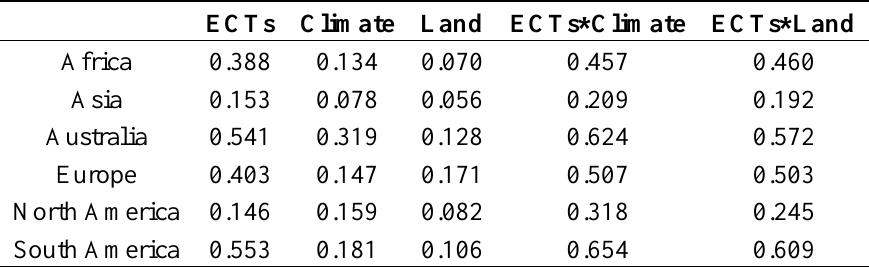
Table 2. Adjusted R 2 values of the univariate one- and two-way Anova models in explaining variance of the FPAR3g-SPEI12 correlations with the ERTs, Köppen climate zones, land use and their combinations as predictors. All models were significant on the p < 0.001 level. ECTs Climate Land ECTs*Climate ECTs*Land